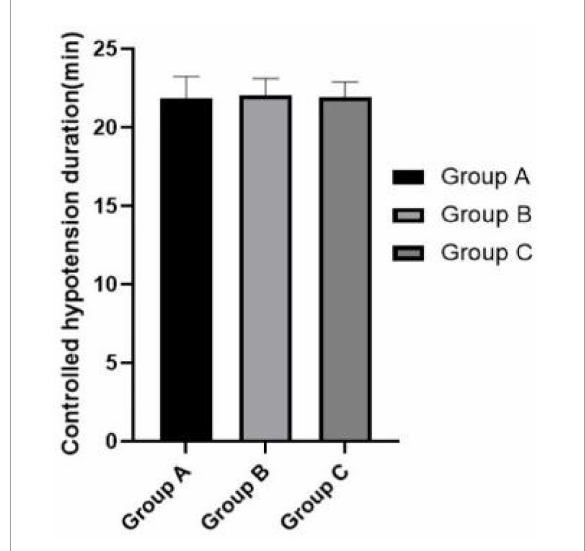
FIGURE4 Comparison of controlled hypotension duration.